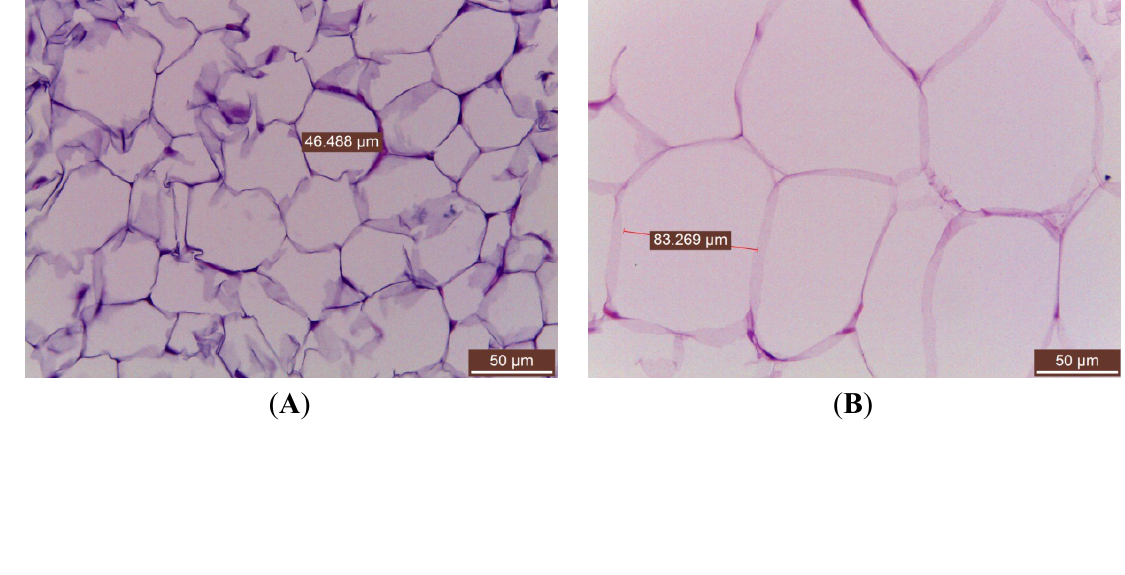
Figure 3. Histology of the epididymal white adipose tissue (WAT) of mice in the ( A ) Low- fat (LF); ( B ) High-fat (HF); ( C ) HF+T1; ( D ) HF+T2; ( E ) HF+T3; or ( F ) HF+Rosi groups. Each presented is typical and representative of nine mice. Magnification: 10 (ocular) × 40 (object lens). T1: 0.2, T2: 0.5 and T3: 1.0 g/kg bodyweight cell suspension culture of Eriobotrya japonica ; Rosi: rosiglitazone (0.01 g/kg body